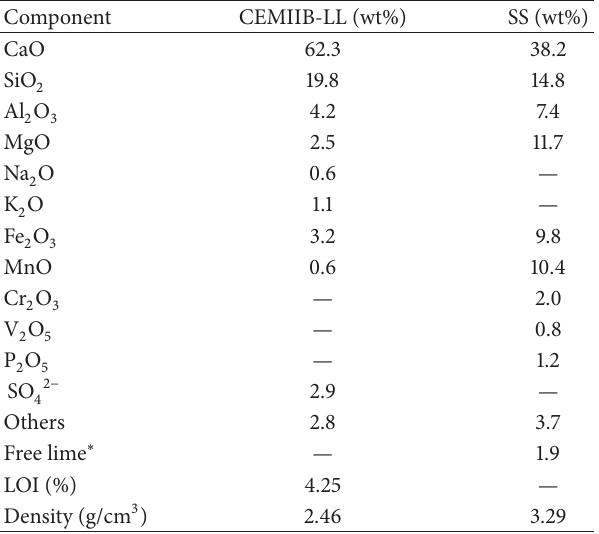
Table 2: Composition, LOI, and density of CEII/B-LL and SS. “Others” indicates the cumulative quantity of all oxides determined in quantity lower than 0.1